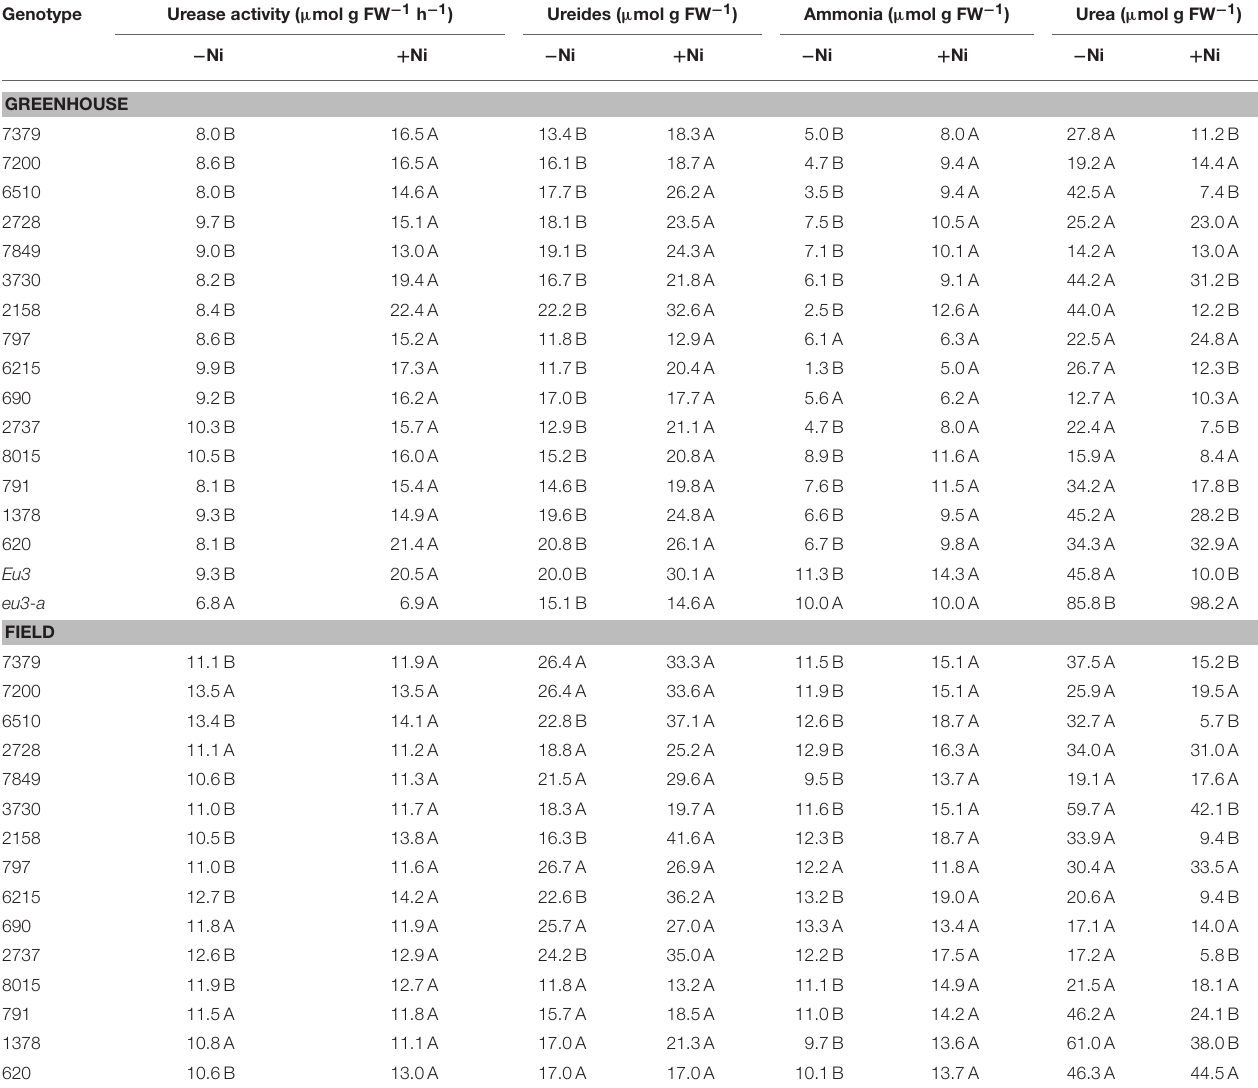
TABLE 5 | Effects on the leaf N metabolism due to fertilization with 0.0mg of Ni kg − 1 ( − Ni) and 0.5mg of Ni kg − 1 ( + Ni) in 15 soybean genotypes and two near-isogenic lines (NILs, Eu3 and eu3-a ) cultivated in greenhouse and field conditions.